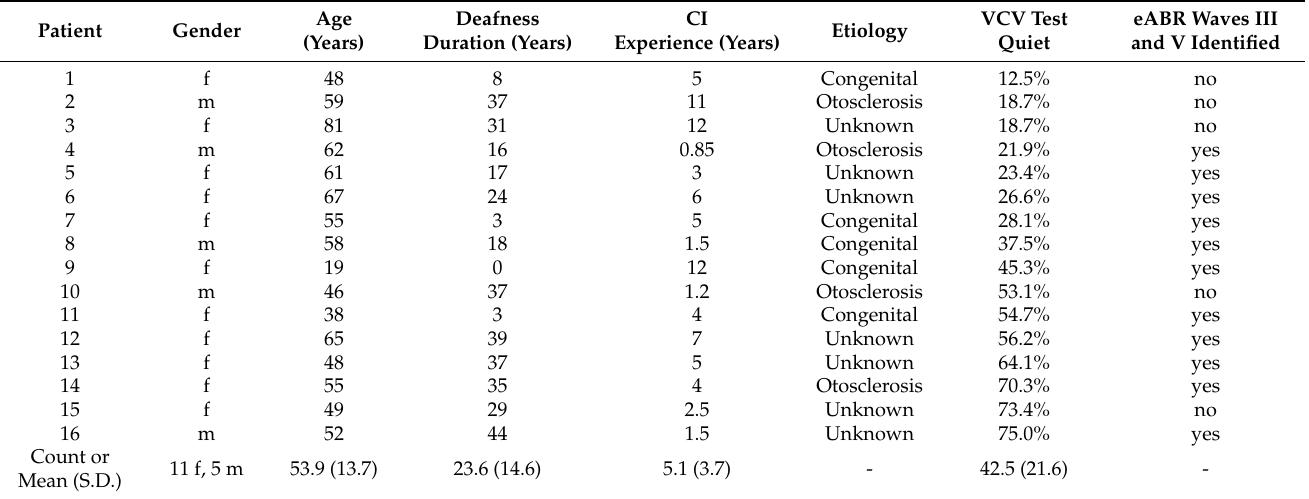
Table 1. Demographic details of included patients, Gender: f: female, m: male; VCV test in quiet: percent correct VCV logatome identification score in